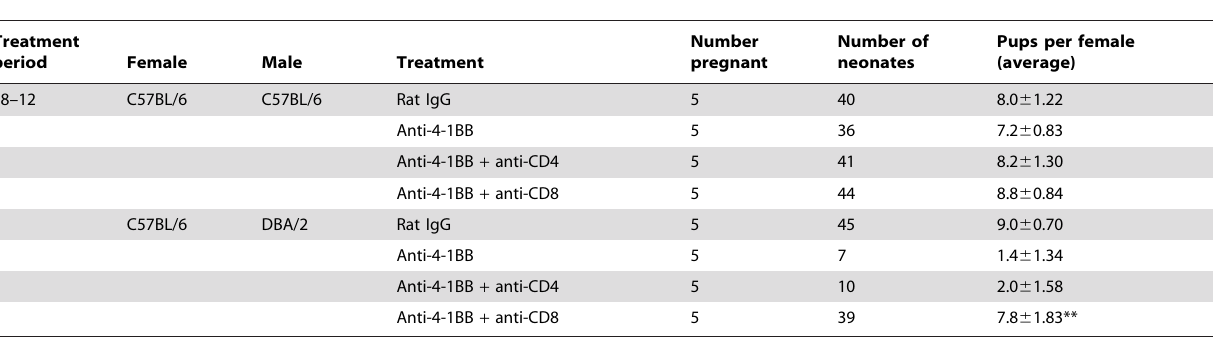
Table 2. CD8 + T cells mediate allogeneic fetal rejection by agonistic anti-4-1BB mAb.